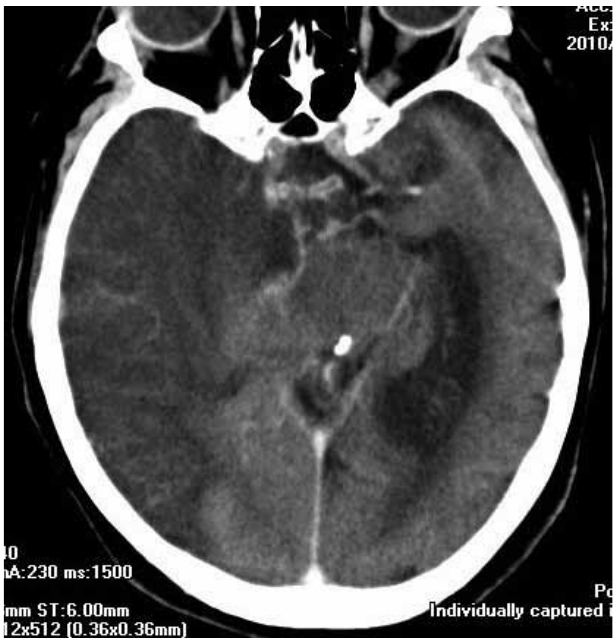
Fig. 3. Enhanced axial CT brain done 5 days later (at the level of the suprasellar cistern) demonstrates evolution of the complete right MCA ischaemic stroke with significant mass effect and features of luxury